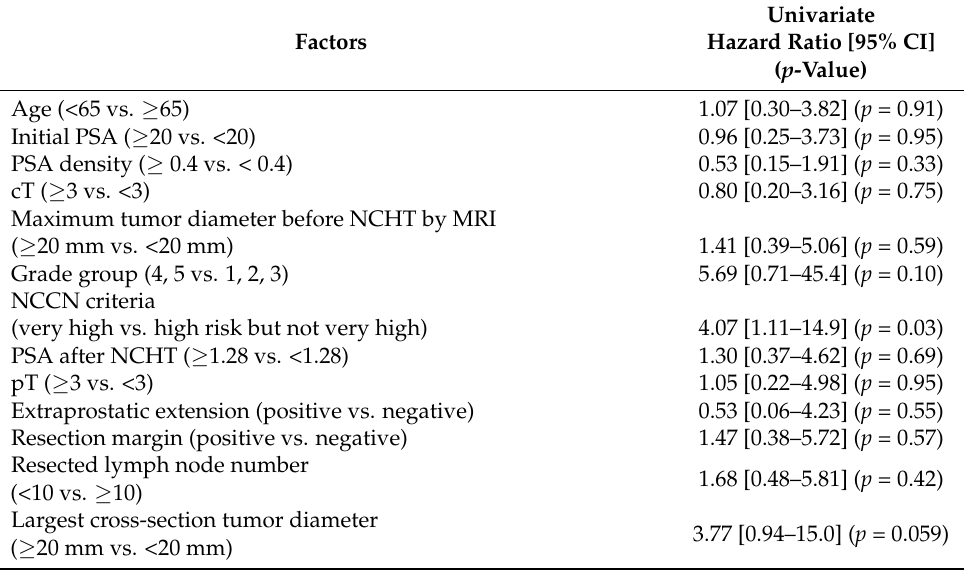
Table 2. Univariate analysis of factors predicting biochemical progression-free survival in high- risk localized prostate cancer patients with neoadjuvant chemohormonal therapy before radical prostatectomy ( n = 21).